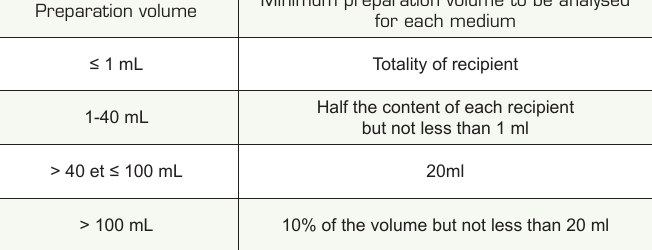
In the special case of antibiotic liquids, the volume prescribed in the pharmacopoeia is 1 ml whatever the preparation volume.